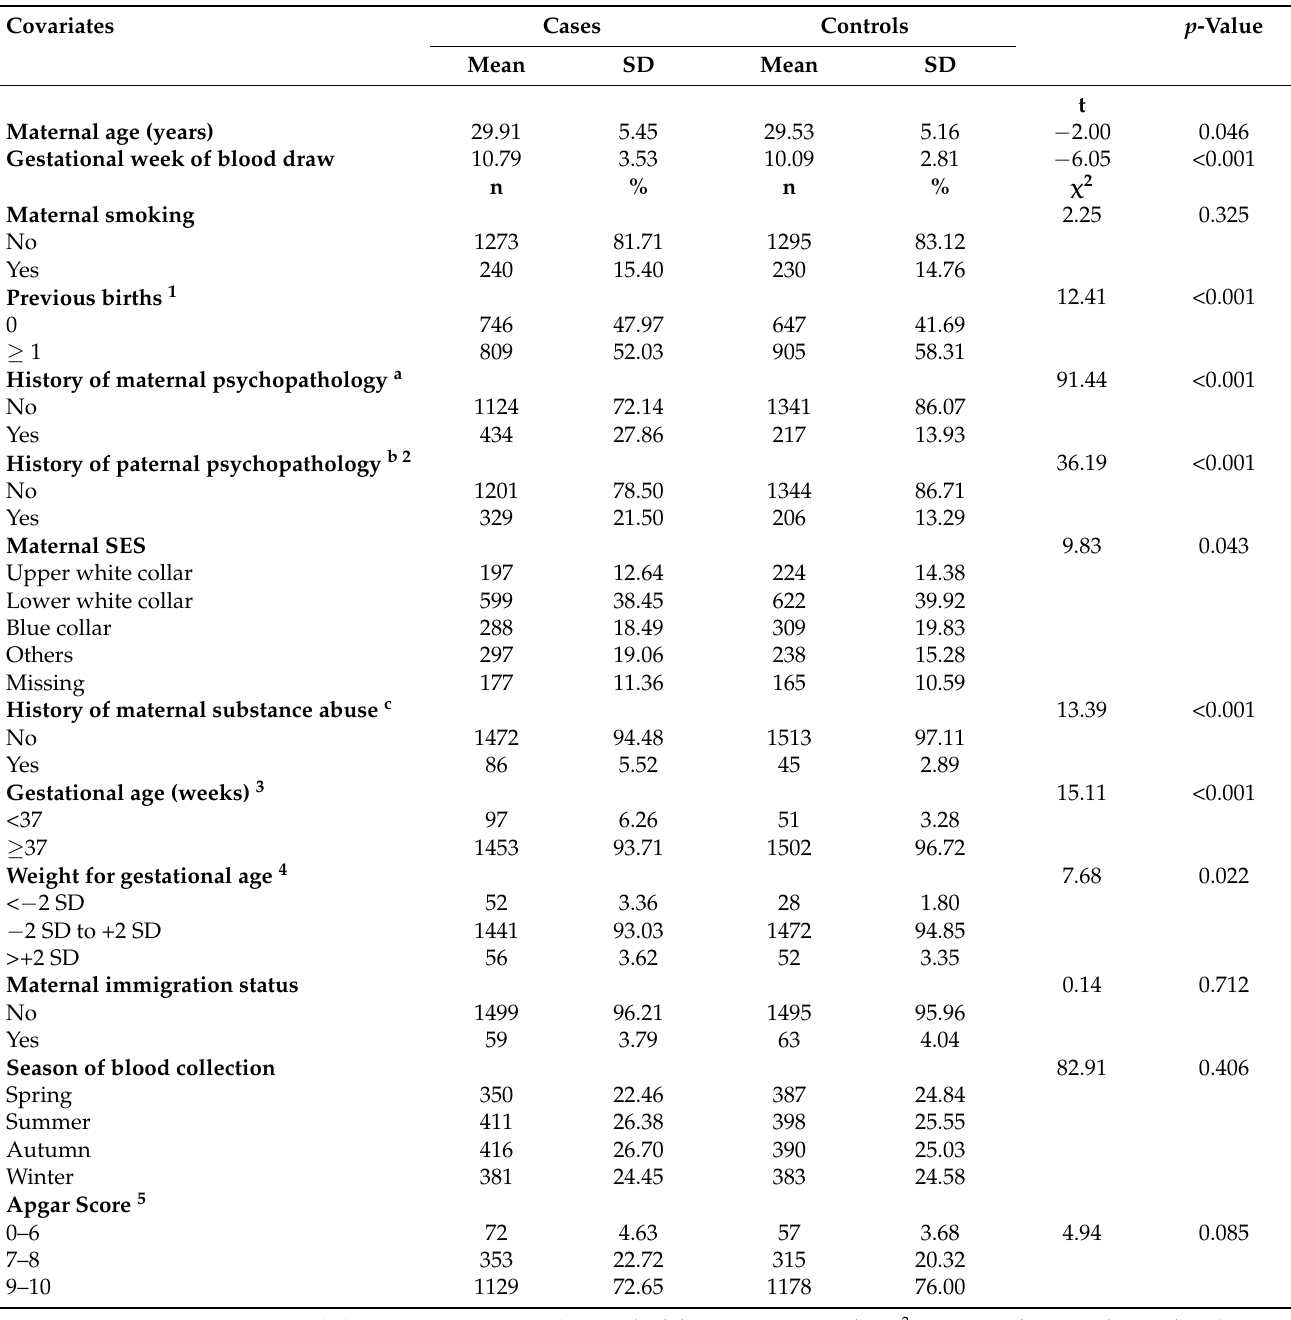
Table 2. Relationship between covariates and ASD in case and control